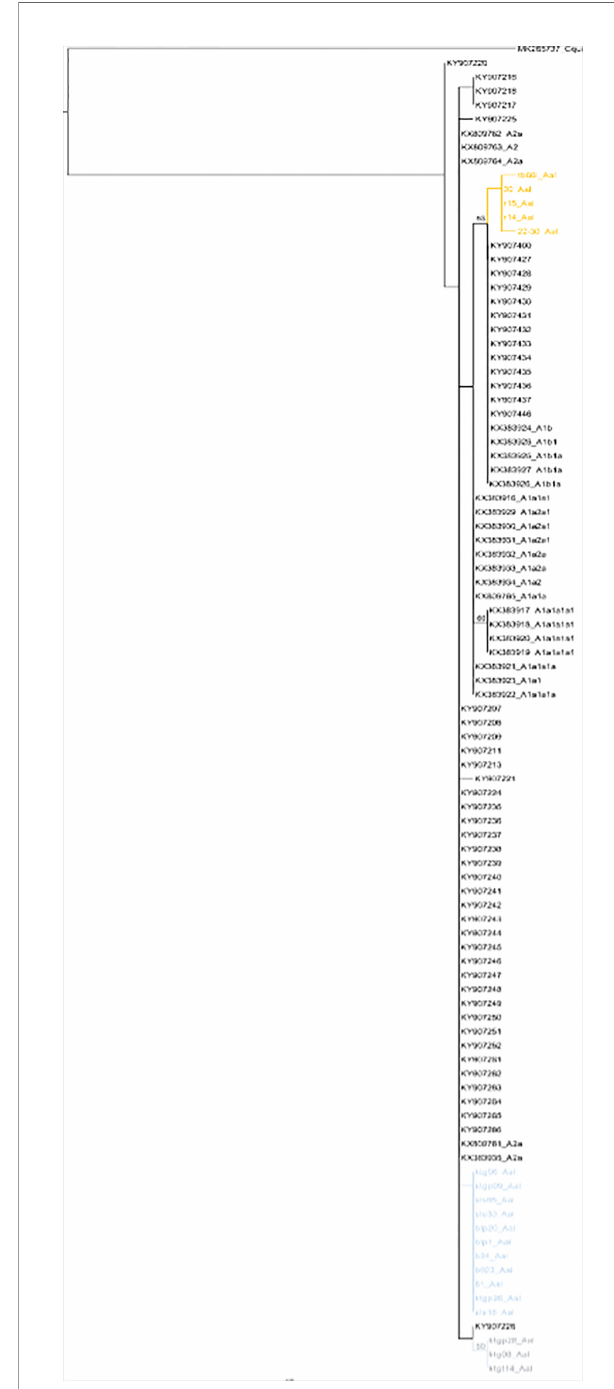
FIGURE 6 | Phylogeny of Aedes albopictus cox 1 genes. The phylogenetic tree was built using maximum-likelihood (ML) with the general time reversible model with gama distributed with four discrete categories (GTR + I + G). The clade support was assessed via 500 bootstrap replicates. The tree was rooted using the Culex quinquefasciatus cox 1 gene (MK265737) as outgroup. The color code used is that of the cox 1 subclusters displayed in Supplementary Table 2 . Gray: Subcluster Aal1, green: Subcluster Aal2, orange: Subcluster